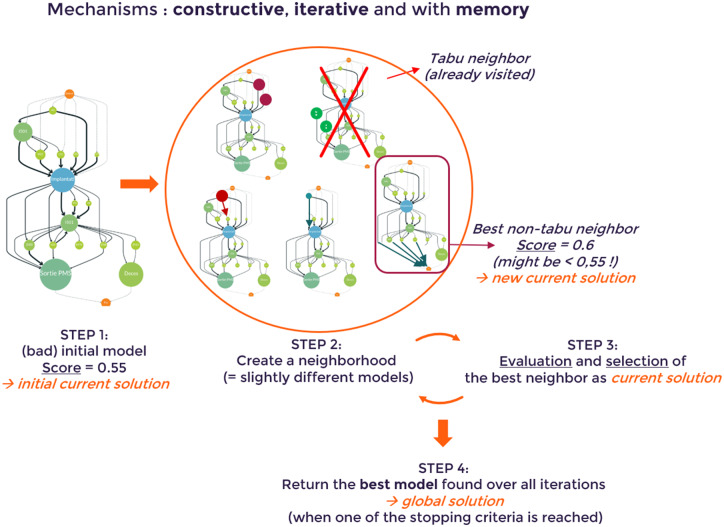
Constructive, iterative, optimal pathway discovery algorithm. The score for each model describes the representativeness of the model. A “new” current solution is only adopted if it scores more highly than the current model. All Tabu neighbors (those that have recently been visited) are censored.